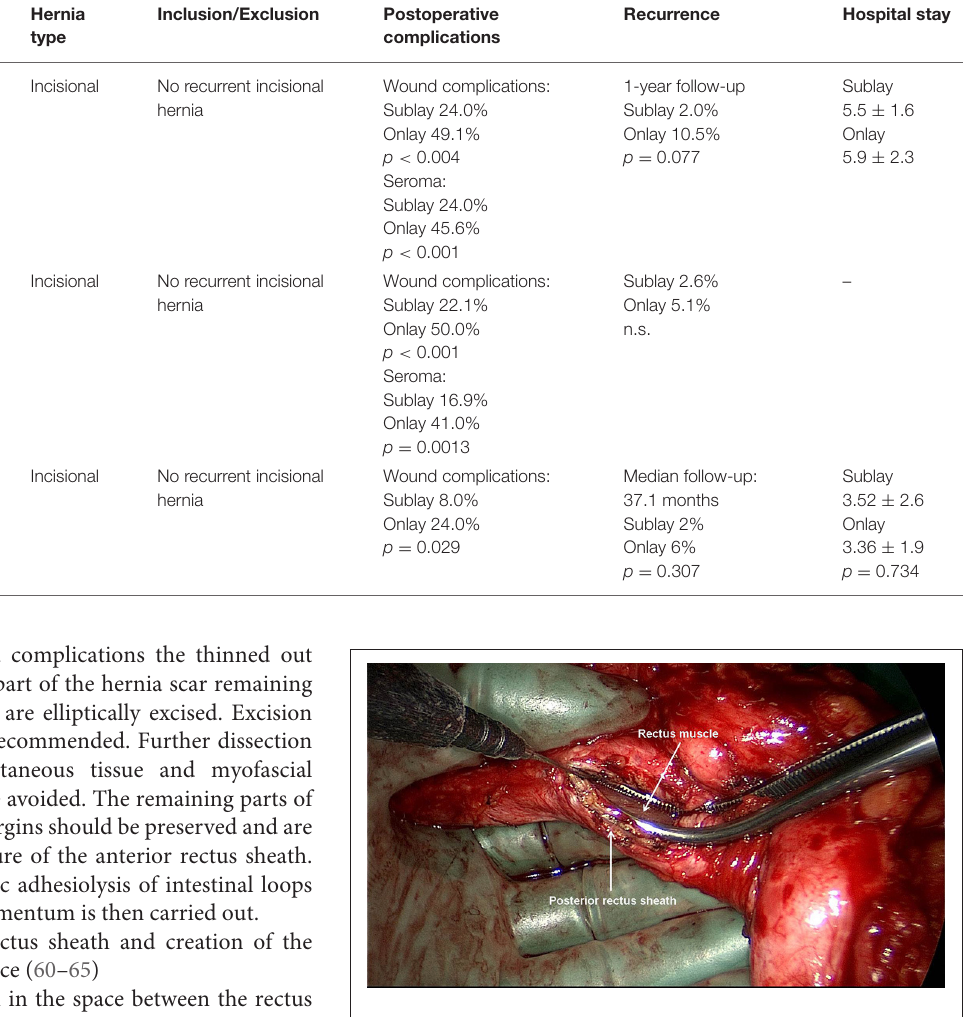
TABLE 3 | RCTs comparing sublay/retro-rectus vs. onlay mesh repair technique in incisional hernia repair.